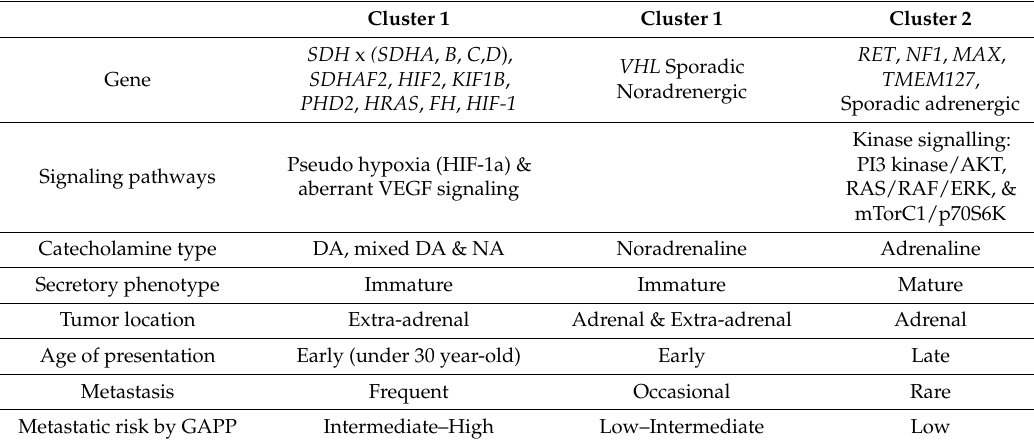
Table 6. Correlation of Cluster Stratification and